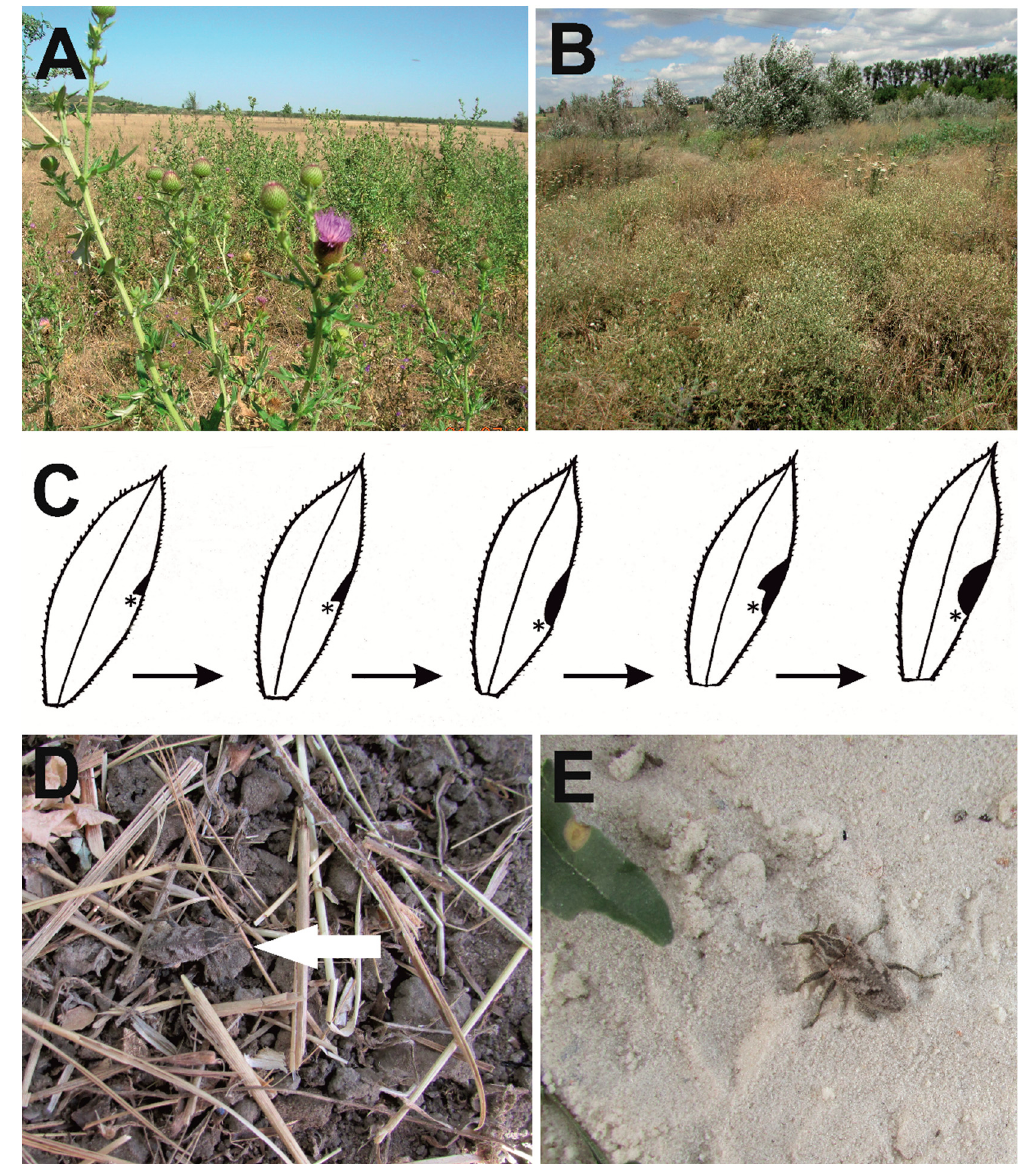
Figure 5. Cleonis pigra habitats. ( A )—habitat with flowering Cirsium ukranicum (near the Kamyana Mohyla Reserve); ( B )—habitat with flowering Centaurea diffusa (Pishchanska Balka); ( C )—the schema how adult of Cleonis pigra eats a leaf of Cirsium setosum . Asterisks mark the beetle location; ( D )— Cleonis pigra on the roadside; ( E )— Cleonis pigra on the seashore. All photos: S. Volovnik.